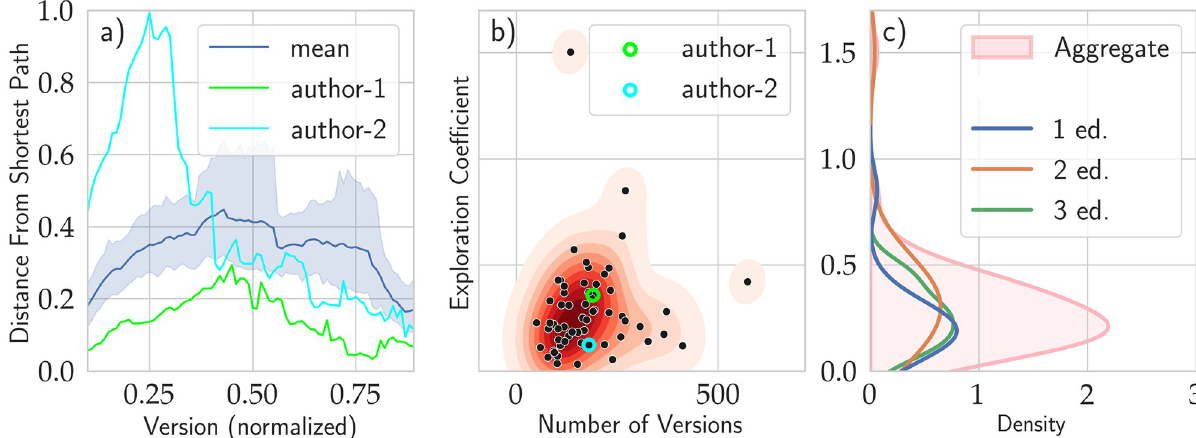
Fig 2. Exploration patterns in writing. (a) Distance from the shortest path during the editing phase from beginning to end for two authors [in cyan and green] and the average behavior of all the authors [dark blue line]. The shortest path would be achieved by someone who never makes revisions to the text. It is evident how the deviation from the shortest path varies strongly throughout the writing process, and it is stronger further from the beginning and the end. The mean curve is displayed as the dark blue line, while the pale blue area outlines the 99.5% confidence interval estimated using the bootstrap technique. (b) Exploration coefficient vs. the number of versions of each document. The Exploration Coefficient shows weak to no correlation with the number of versions, Pearson R = 0.10, p = 0.44. The values for the two versions presented on the left are outlined with circles of the same color. (c) Distribution of the Exploration Coefficient, defined as the area under the curves of the left panel, aggregated over all workshops [pink] and separately for each workshop.